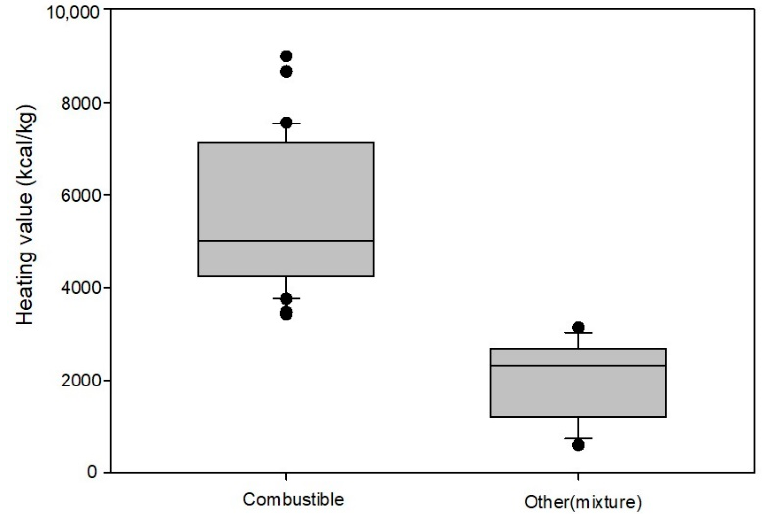
Figure 3. Heating value of residues from SRF facilities.